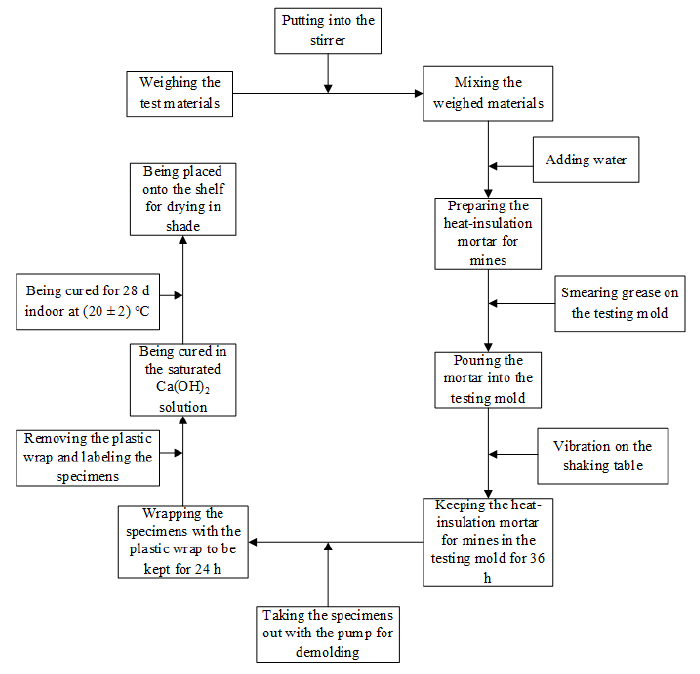
Figure 1. Specimen preparation.